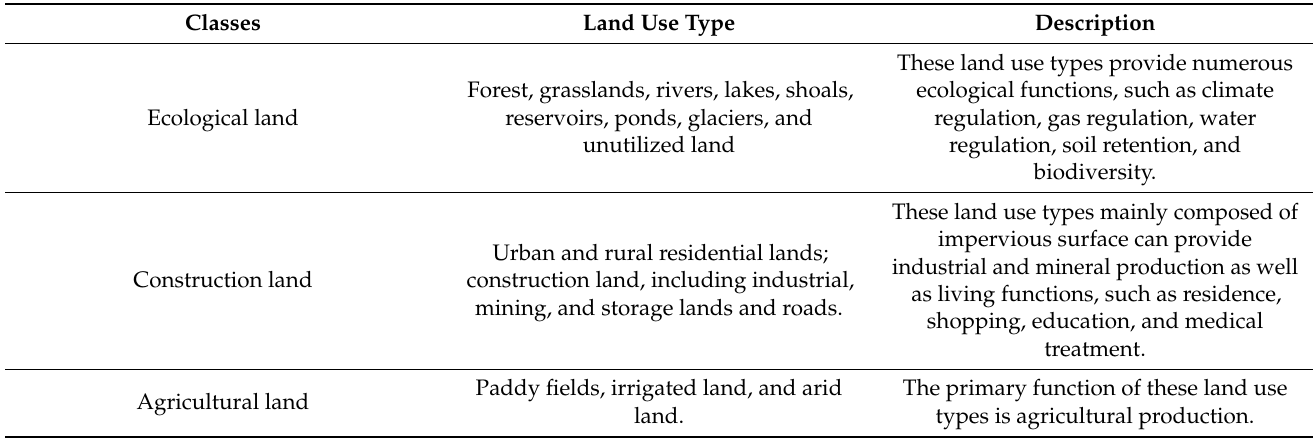
Table 2. Land use classification